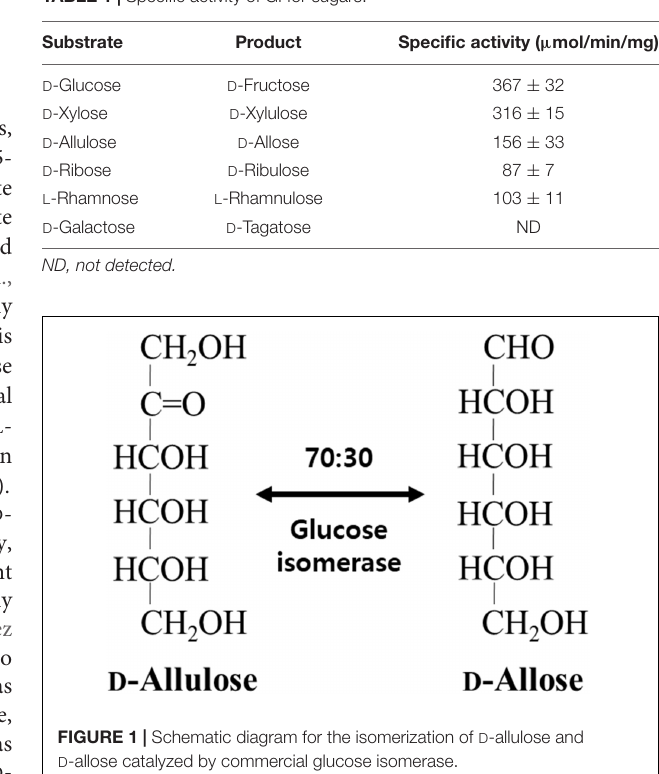
TABLE 1 | Specific activity of GI for sugars.